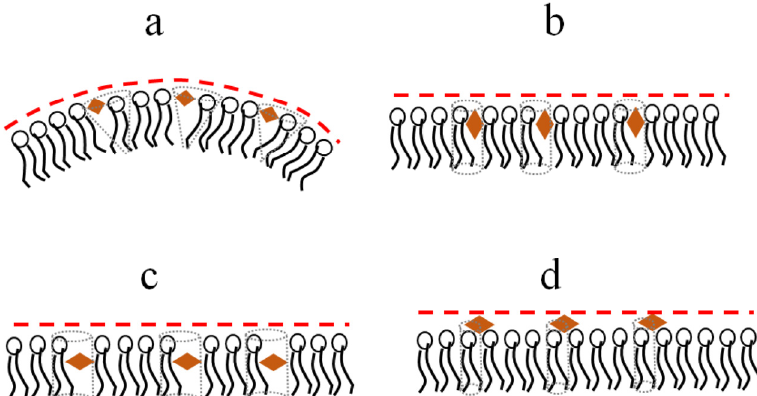
Figure 3. Schematic representation of the immersion of different polyphenols (orange diamonds) into membrane and their influence on lipid packing and curvature stress ( a ) Piceatannol, ( b ) Genistein, ( c ) Isoliquiritigenin, ( d ) Genistin.